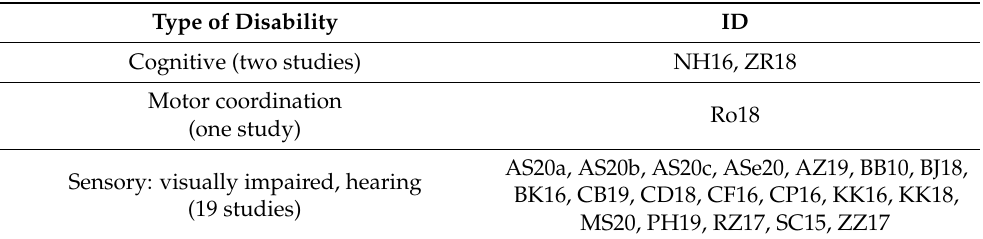
Table 5. Studies by disability.